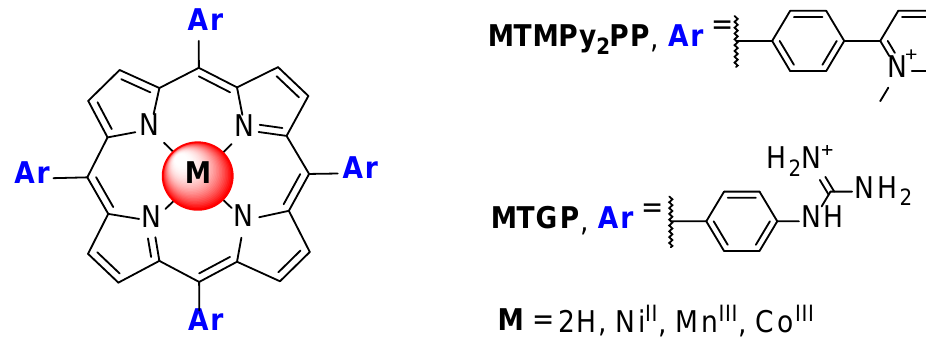
Figure 12. Structures of 5,10,15,20-tetrakis(4-( N -methyl-pyridinium-2-yl)phenyl)-porphyrin (MTMPy 2 PP) and 5,10,15,20-tetrakis(4-guanidinophenyl)porphyrin (TGP) derivatives, studied by Sabater et al. [73].